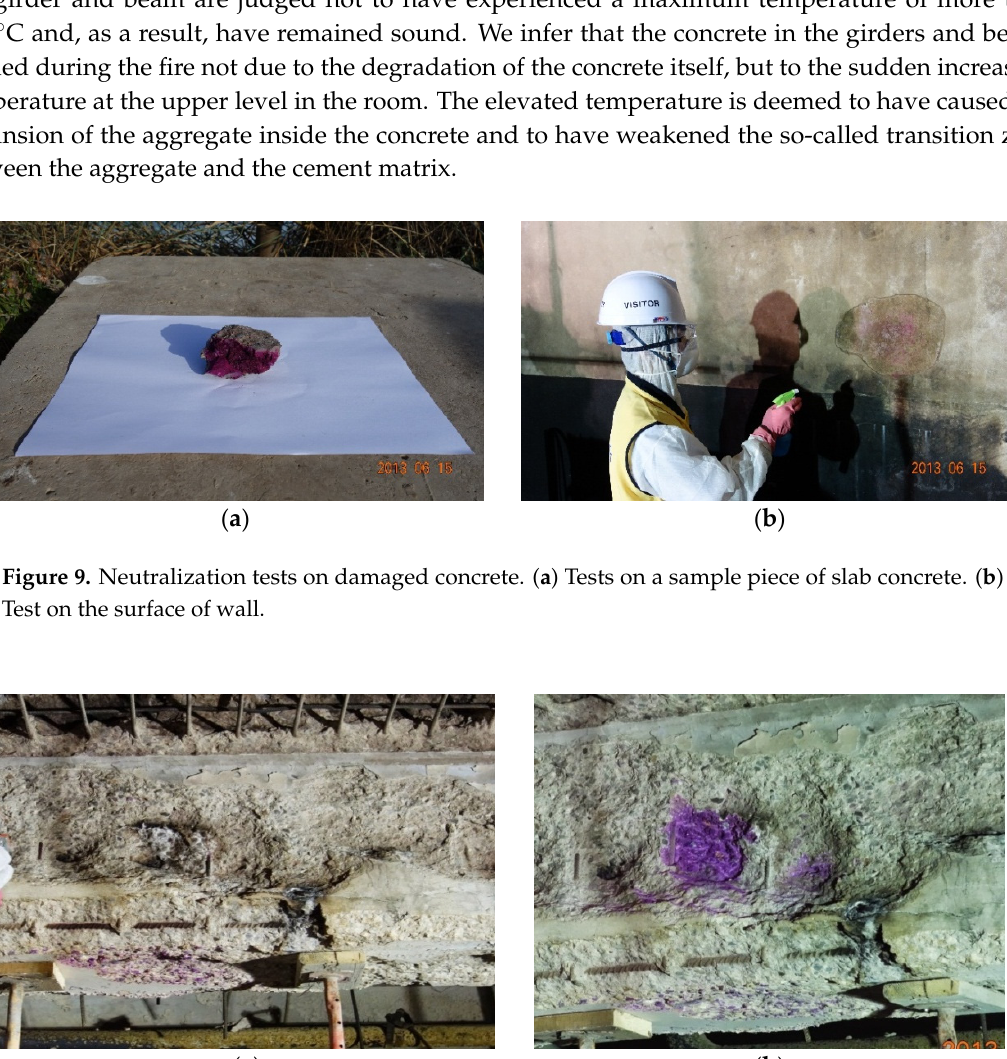
Figure 10. Neutralization test on ( a ) the side surface and ( b ) inside of Beam #2.